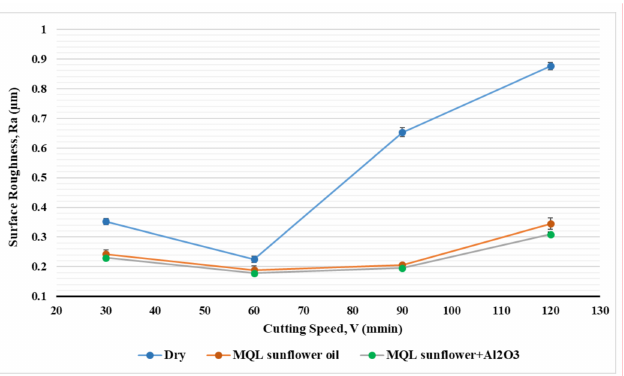
Figure 10. Effect of cooling strategies on surface roughness under different cutting speeds.